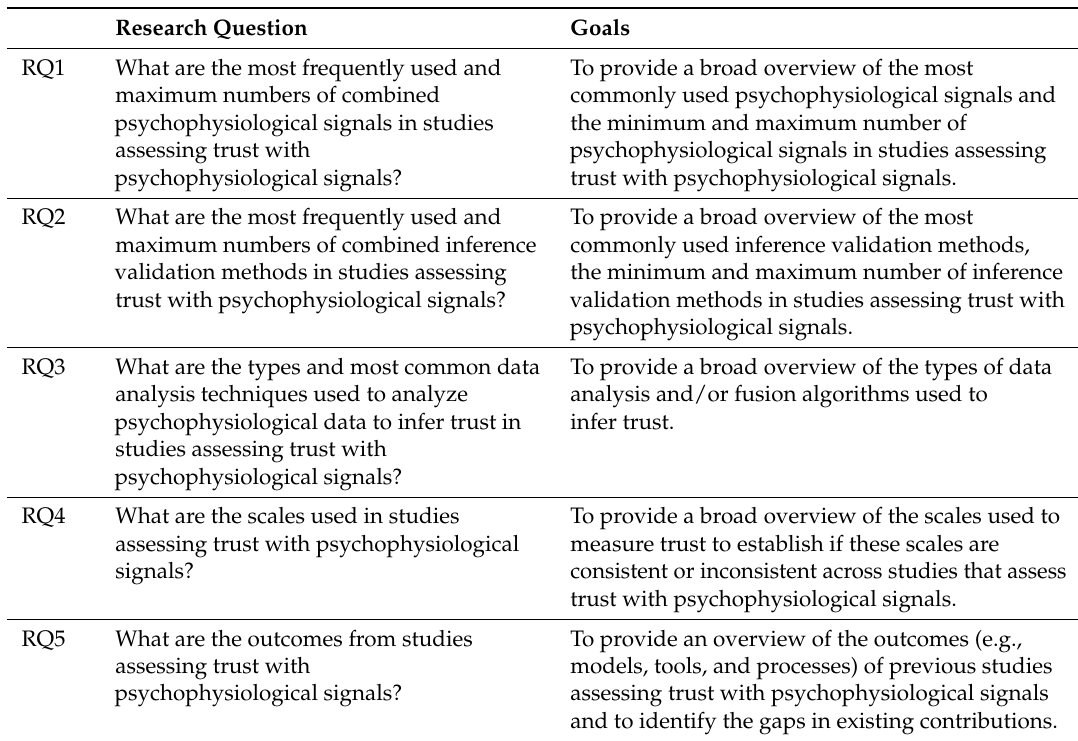
Table 1. Research